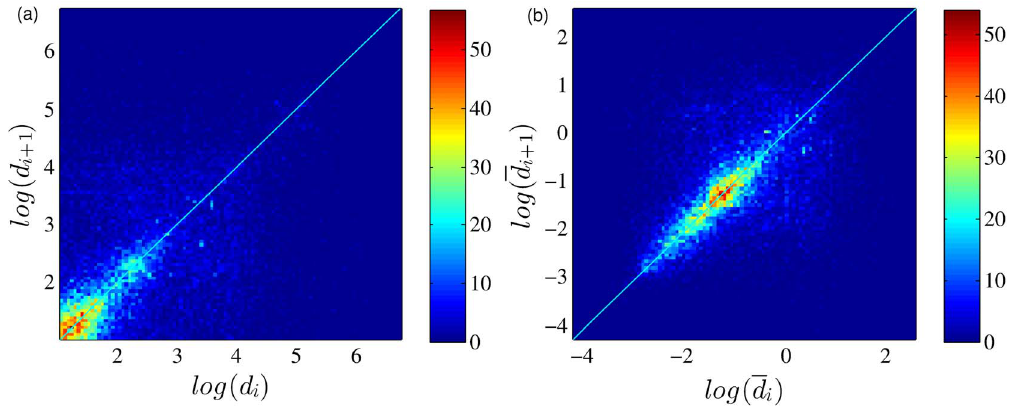
Figure 4. Aggregated displacement correlations d i vs. d i z 1 (a) and (cid:2) dd i vs. (cid:2) dd i z 1 (b) in scatter plot. The figure shows a high density of points near the diagonal line d i z 1 ~ d i .